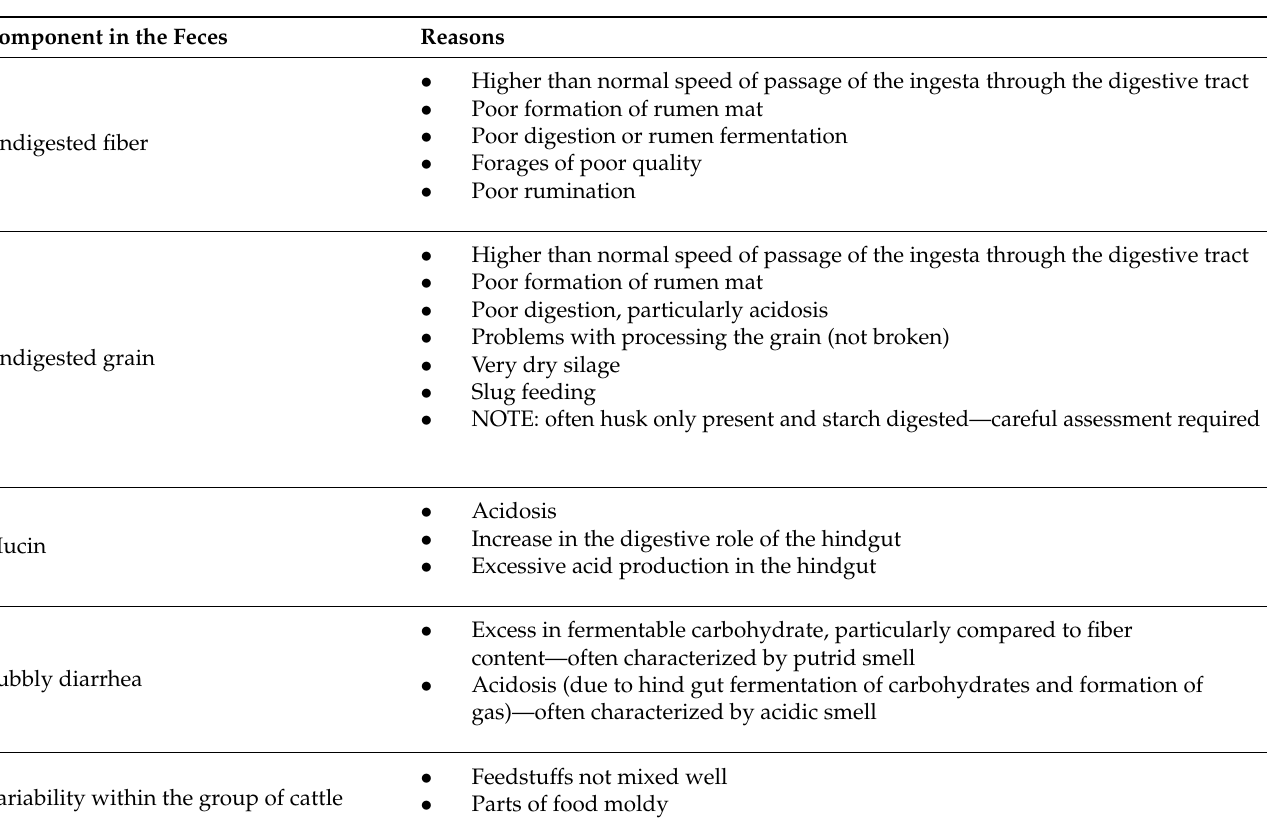
Table 6. Admixtures of feces and common reasons related to nutrition, excluding pathologic condi- tions associated with various infectious